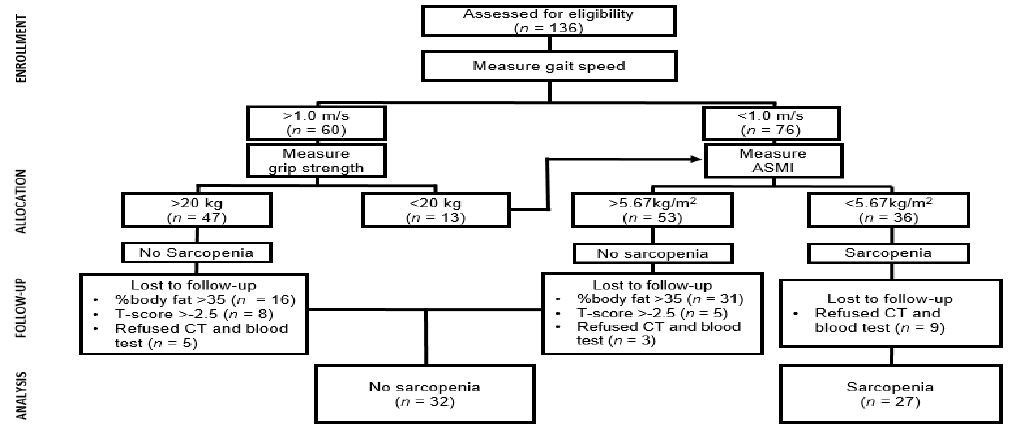
Figure 1. Flow chart of the study.